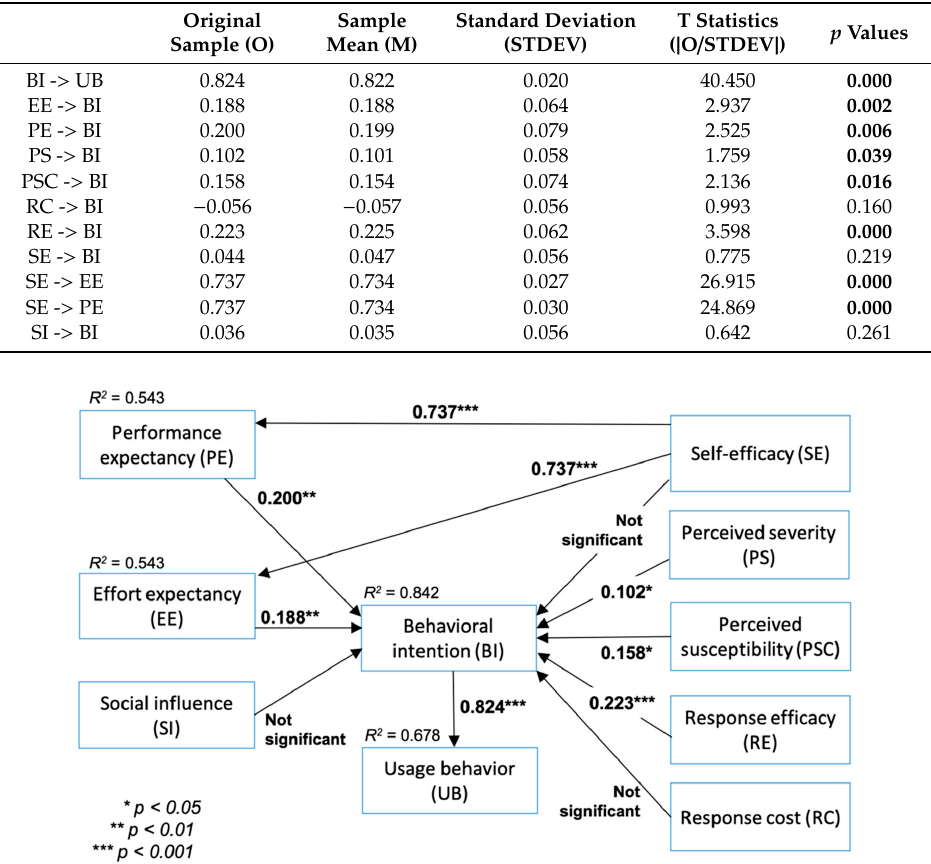
Figure 3. Hypothesis testing based on the structural model evaluation results, statistical significance, and the relevance of the path coe ffi cients. Behavioral intention was significantly a ff ected by performance expectancy (PE), e ff ort expectancy (EE), perceived severity (PS), perceived susceptibility (PSC), and response e ffi cacy (RE), and that behavioral intention corresponded positively to usage